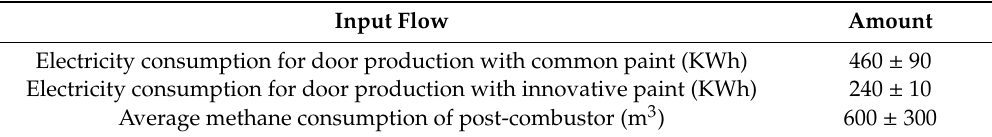
Table 1. Process consumptions considered for the LCA (functional unit: 10 tons of wood products).